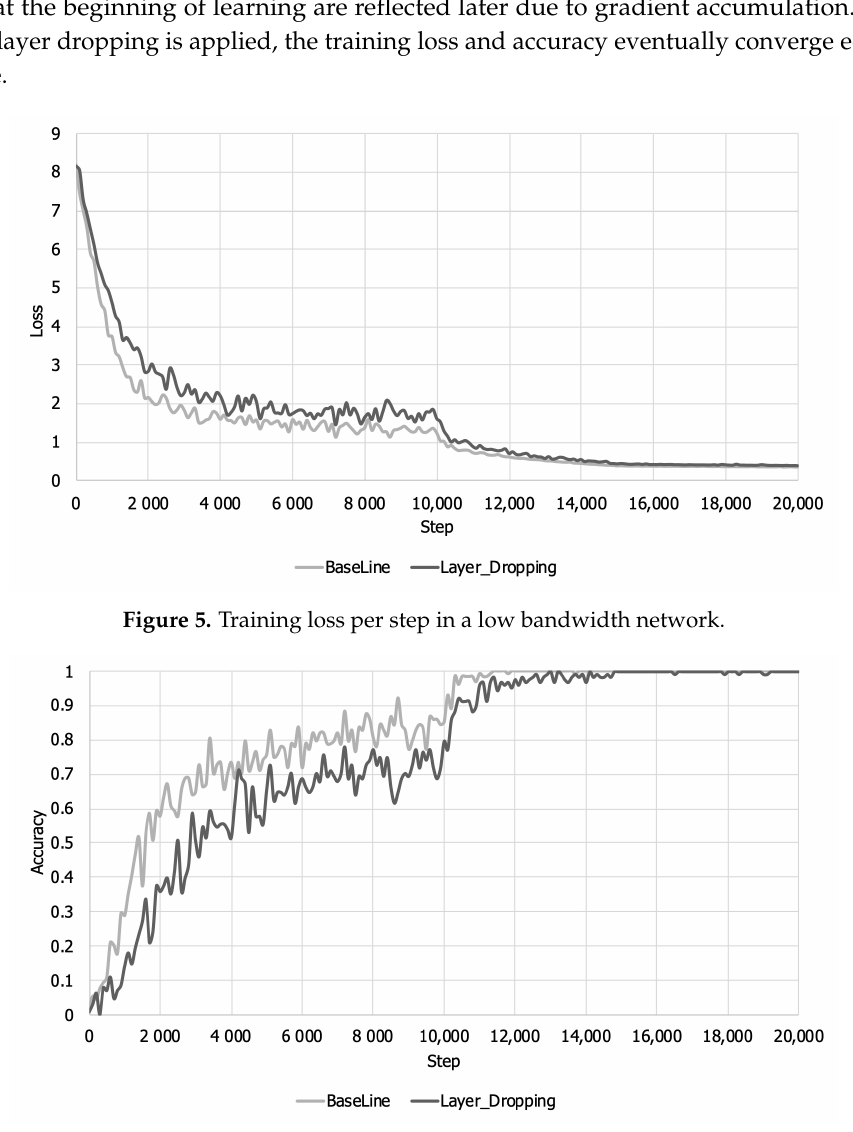
Figure 6. Training accuracy per step in a low bandwidth